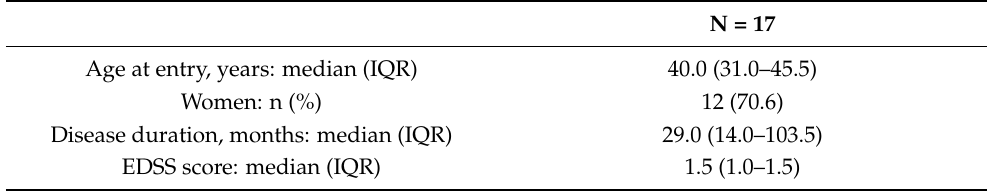
Table 1. Demographic and clinical characteristics of 17 relapsing–remitting multiple sclerosis patients receiving dimethyl fumarate. EDSS, expanded disability status score; IQR: interquartile